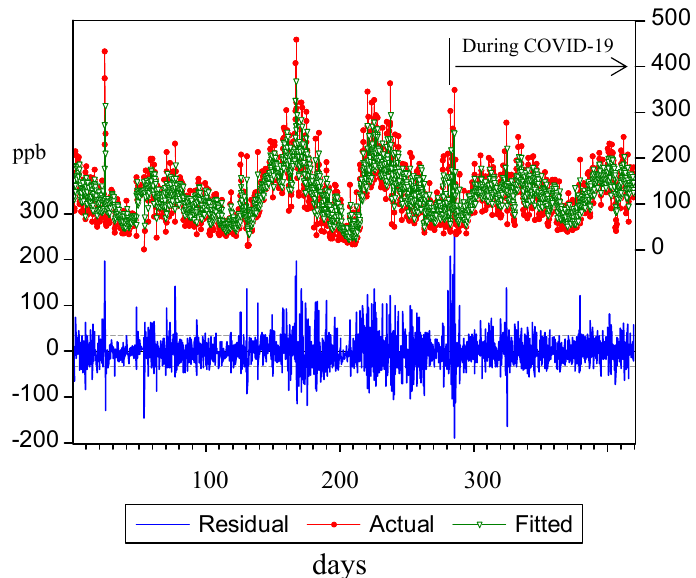
Figure 4. Estimation of the concentration of NO 2 with the VARMA (1,1)-EGARCH (1,1) model.